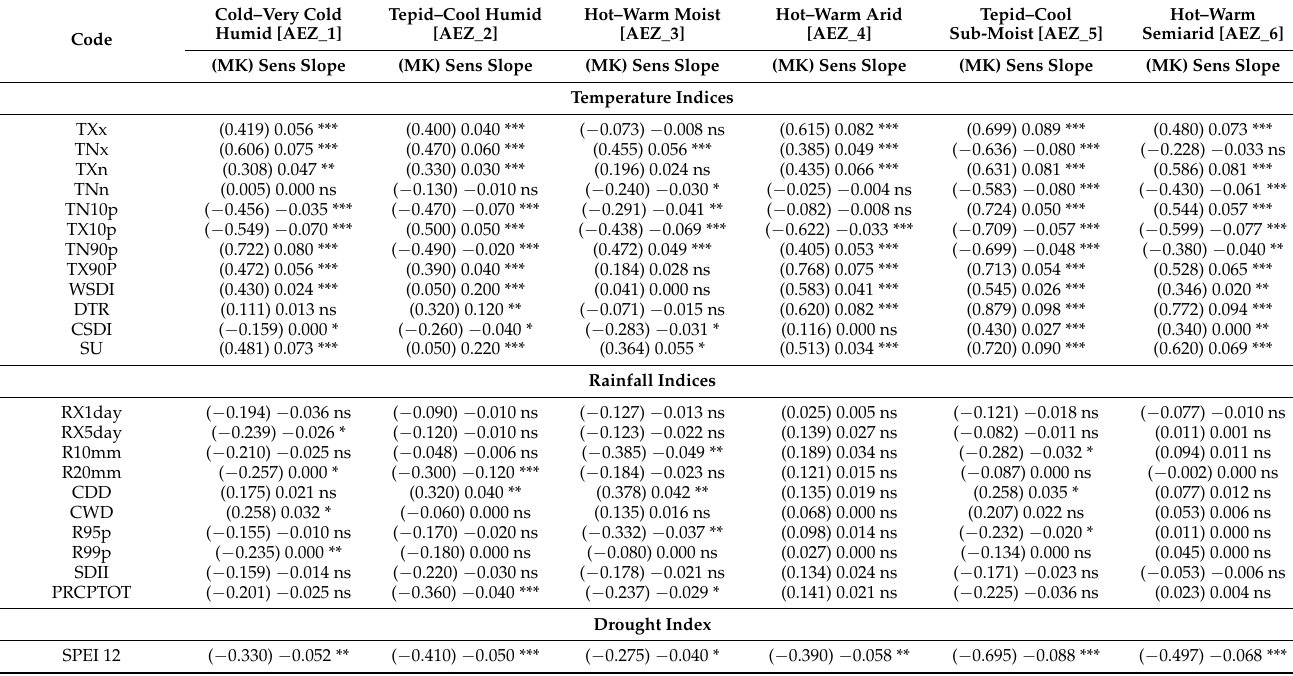
Table 2. Trends of ET_SCI extreme indices.